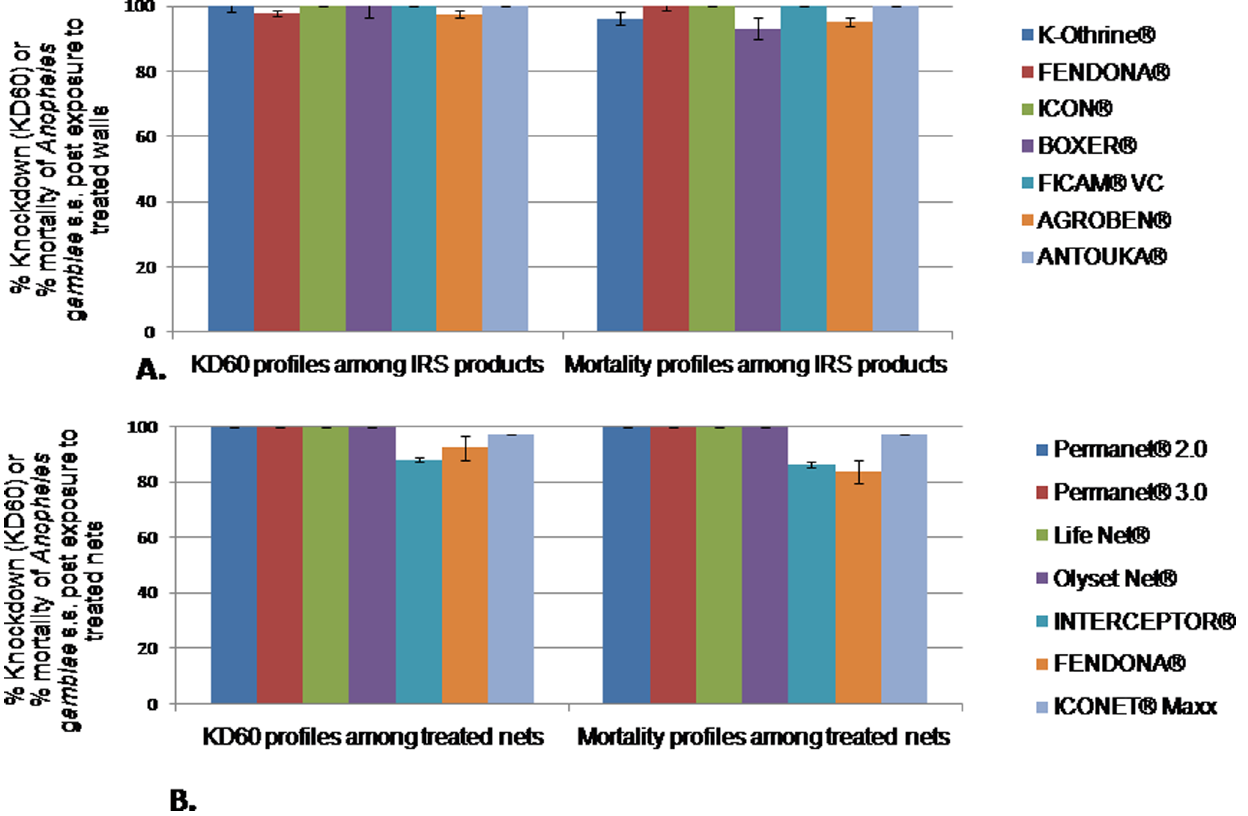
Figure 1. Knockdown and mortality rates of susceptible Anophelesgambiae s.s. post contact with different insecticide treatments. A: Indoor Residual Spraying; B: Long lasting insecticidal nets; KD60: knockdown rate of mosquitoes 60 minutes post contact to treated material. All tested IRS insecticide formulations were found effective although a decrease of insecticide activity was seen with lambda cyhalothrin 10 WP (P , 0.05). All tested insecticidal nets were found effective although a decrease of insecticide activity was seen with alpha cypermethrin conventional or long lasting treated nets (P , 0.05).